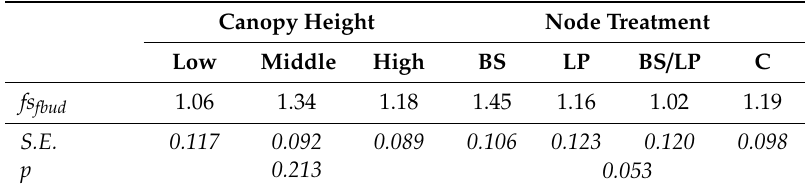
Table 4. The mean number of fruit set per floral bud ( fs fbud ) for each canopy height (low, middle, high; p = 0.213) and for each node treatment (BS = bud shading; LP = leaf pluck; BS / LP = bud shading plus leaf pluck; C = control; p = 0.053). S.E. represents the standard errors of the means. p represents the probability value. Canopy Height Node Treatment Low Middle High BS LP BS / LP